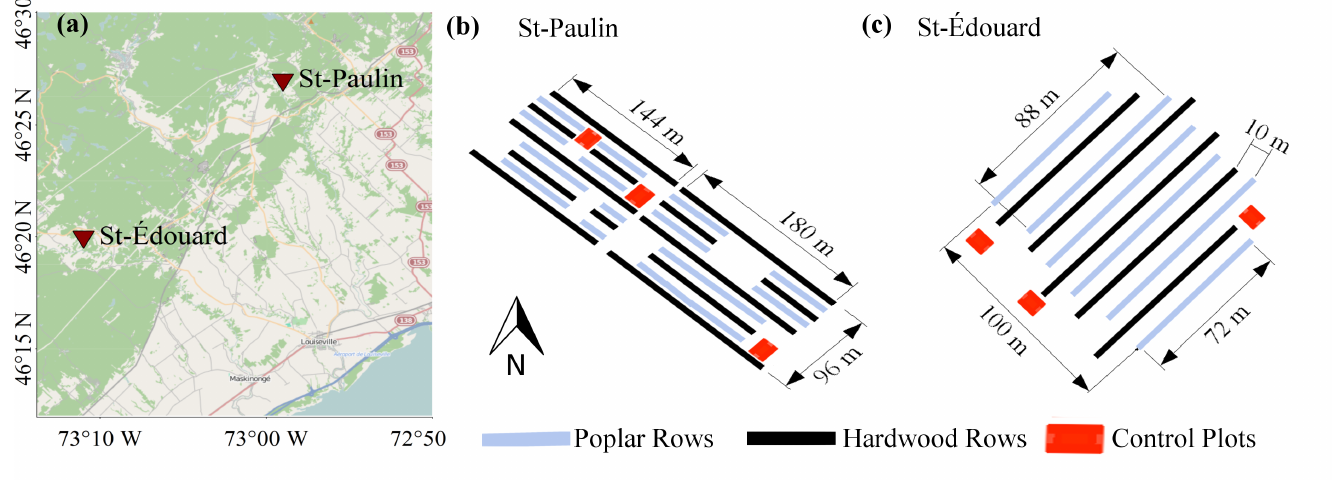
Figure 1. Maps indicating ( a ) the location of the tree-based intercropping (TBI) sites in southern Quebec, Canada ( © OpenStreetMap contributors), and the site layouts at ( b ) St. Paulin and ( c ) St.